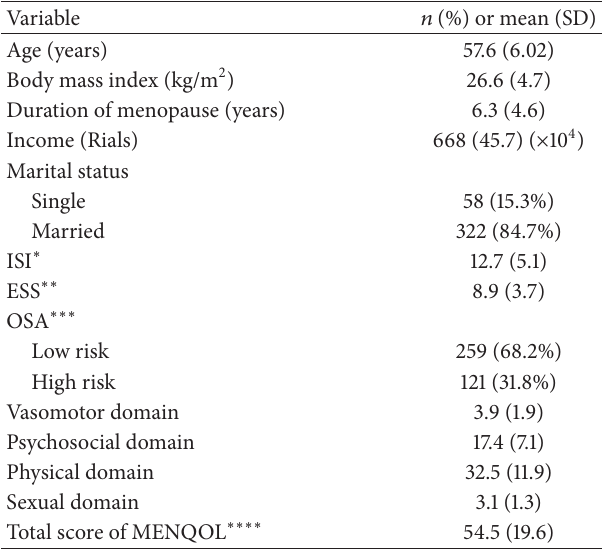
Table 1: Demographic and clinical characteristics of